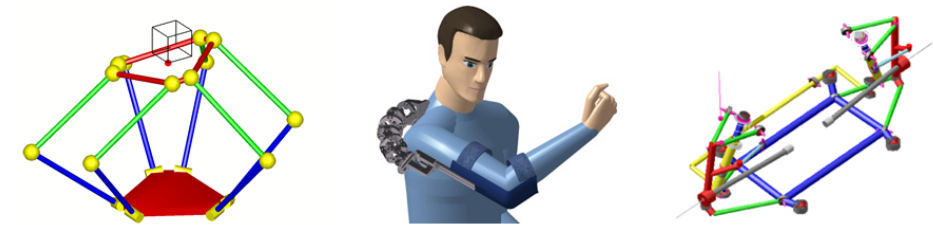
Figure 3. Closed-loop MBS (ROBOTRAN